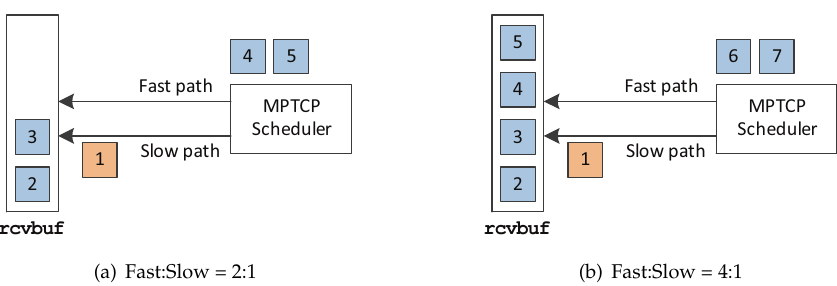
Figure 1. An example of the buffer blocking problem [Fast:Slow] shows the the relative speeds of the two paths. The left subfigure shows that the fast path is two times faster, while the right subfigure shows that the fast path is four times fast.